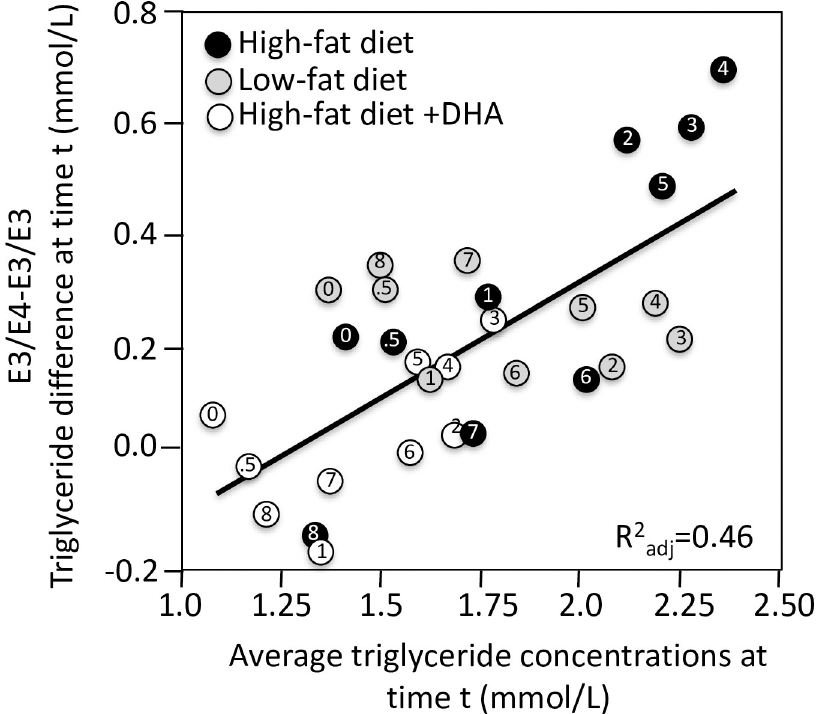
Fig 13. Quantile-dependent expressivity plots for postprandial triglyceride responses by APOE polymorphisms and diet. Derived from the postprandial response figures published by Jackson et al. for differences between 11 APOE E34 vs. 12 E33 men on low-fat diet; high saturated-fat diet; and high saturated-fat diet with fish oil [53].